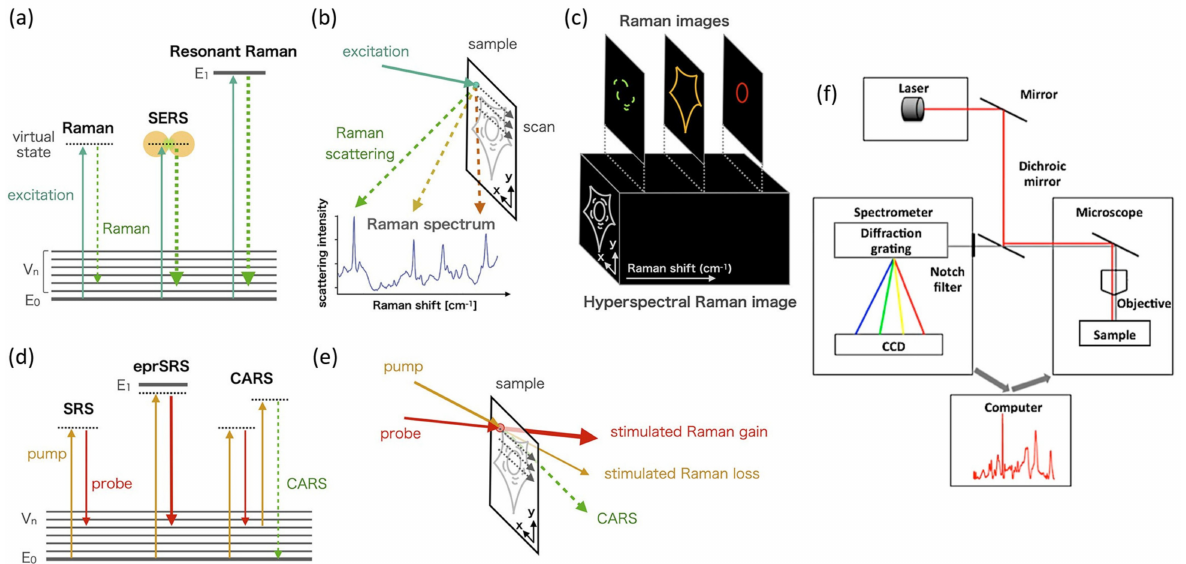
Figure 1. Principles of RS: ( a ) energy level diagram showing Raman scattering, SERS, and RRS. E 0 , E 1 , and V n show the electronic ground state, an electronic excited state, and vibrational excited states, respectively. ( b ) Raman spectrum induced by laser light focused on a sample during Raman microscopy. ( c ) Spatial distribution of Raman spectra, also referred to as hyperspectral Raman images, where Raman images are obtained as distributions of Raman peak intensities. ( d ) Energy level diagram of SRS, electronic pre-resonant stimulated Raman scattering (eprSRS), and CARS. ( e ) SRS microscopy detects the energy exchange between the pump and probe beams via the vibrational excitation state as stimulated Raman gain (probe beam) or loss (pump beam) to reconstruct a Raman image. CARS microscopy uses CARS signals emitted from the sample as the image contrast. Adapted with permission from Reference [11] © 2021 American Chemical Society. ( f ) Generic setup for a Raman microspectroscopy system. Adapted with permission from Reference [12] © 2018 American Chemical